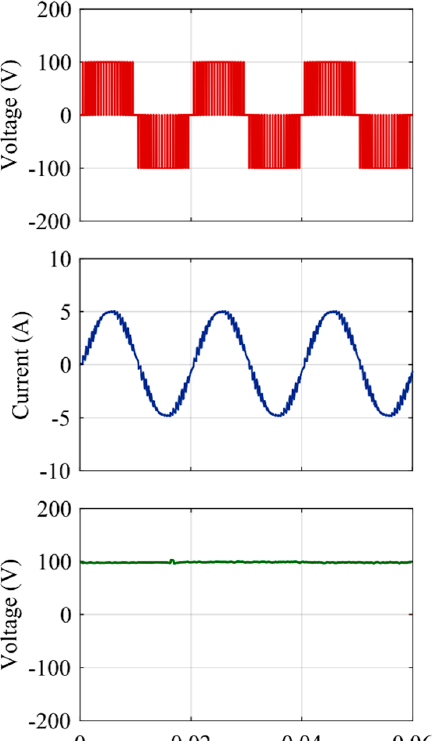
Figure 14. Relative permeability of Mn Zn ferrite under different switching frequencies.